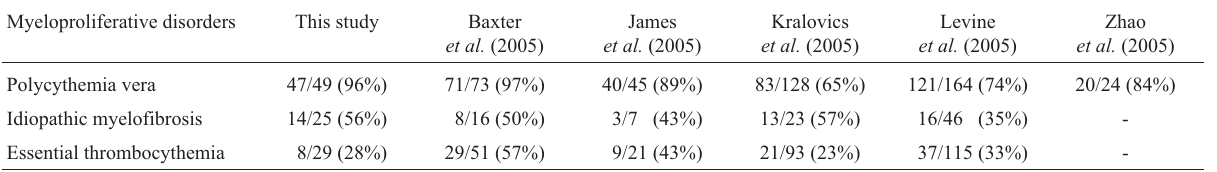
Table 1 - Frequencies of the JAK2 V617F mutation in Brazilian patients and in patients from the literature presenting with polycythemia vera, idiopathic myelofibrosis and essential thrombocythemia. Myeloproliferative